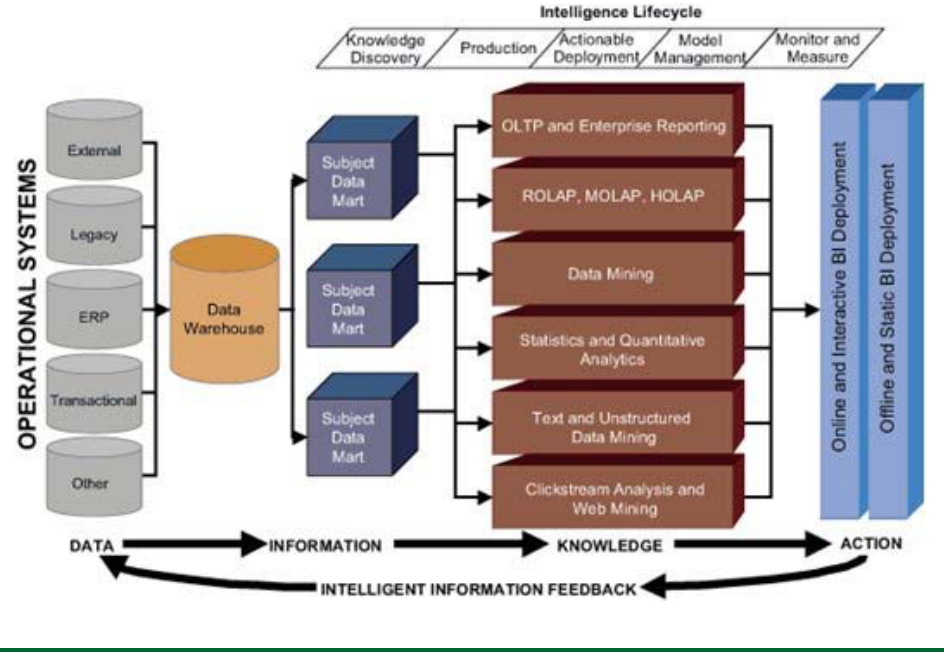
Figure 1 Conceptual business intelligence infrastructure (Source: Gartner Group